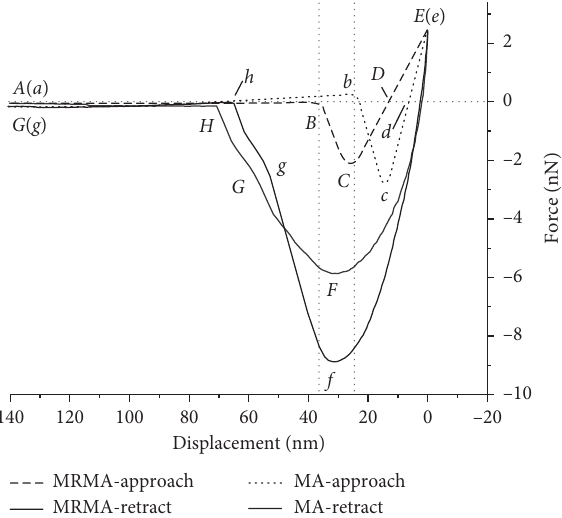
Figure 7: Force-displacement